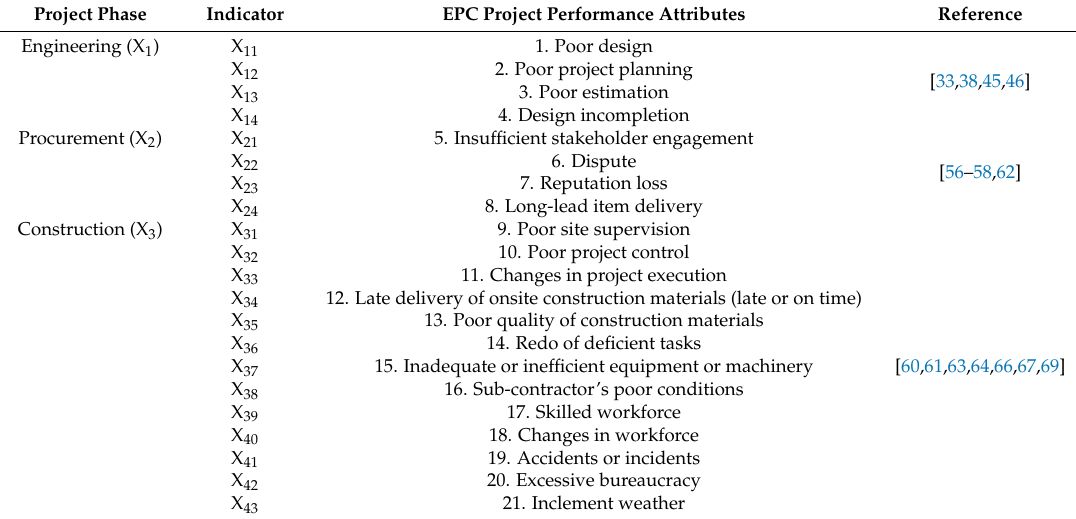
Table 2. Attributes and Initial Measurement